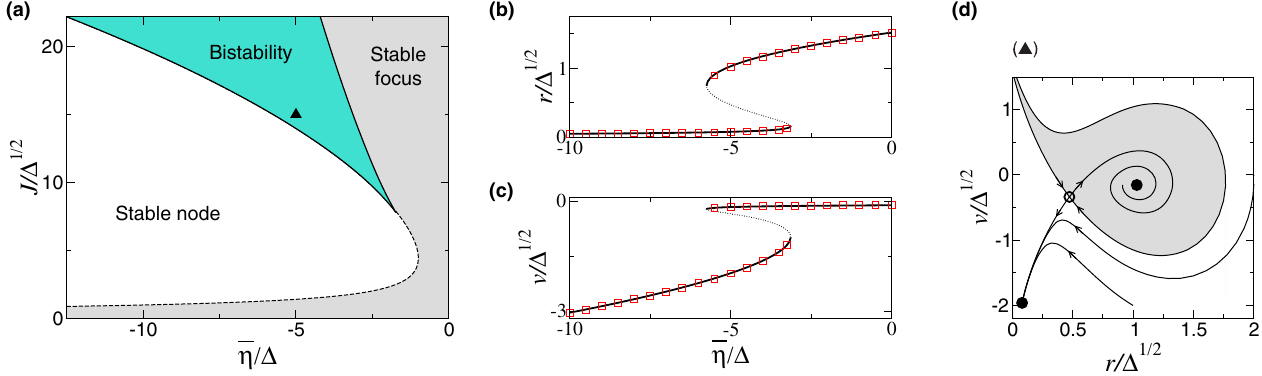
FIG. 1. Analysis of the steady states of FREs (12). (a) Phase diagram: In the wedge-shaped cyan-shaded region there is bistability between a high- and a low-activity state. The boundary of the bistability region is the locus of a saddle-node bifurcation which is exactly obtained in parametric form: ð ¯ η ; J Þ ¼ ½ − π 2 r 2 − 3 Δ 2 = ð 2 π r Þ 2 ; 2 π 2 r þ Δ 2 = ð 2 π 2 r 3 Þ(cid:2) . To the right of the dashed line, defined by SN ¯ η − ½ J= ð 2 π Þ(cid:2) 2 − ð π Δ =J Þ 2 , there is a stable focus (shaded regions). (b) r − ¯ η and (c) v − ¯ η bifurcation diagrams for J= Δ 1 = 2 ¼ 15 . f ¼ Square symbols: Results obtained from numerical simulations of QIF neurons (see Appendix A for details). (d) Phase portrait of the system in the bistable region [ ¯ η = Δ ¼ − 5 ; J= Δ 1 = 2 ¼ 15 , triangle in (a)] with three fixed points: a stable focus (with its basin of attraction shaded), a stable node, and a saddle